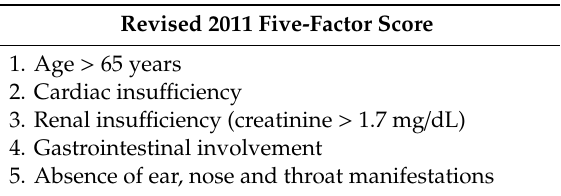
Table 2. Prognostic criteria predicting survival in